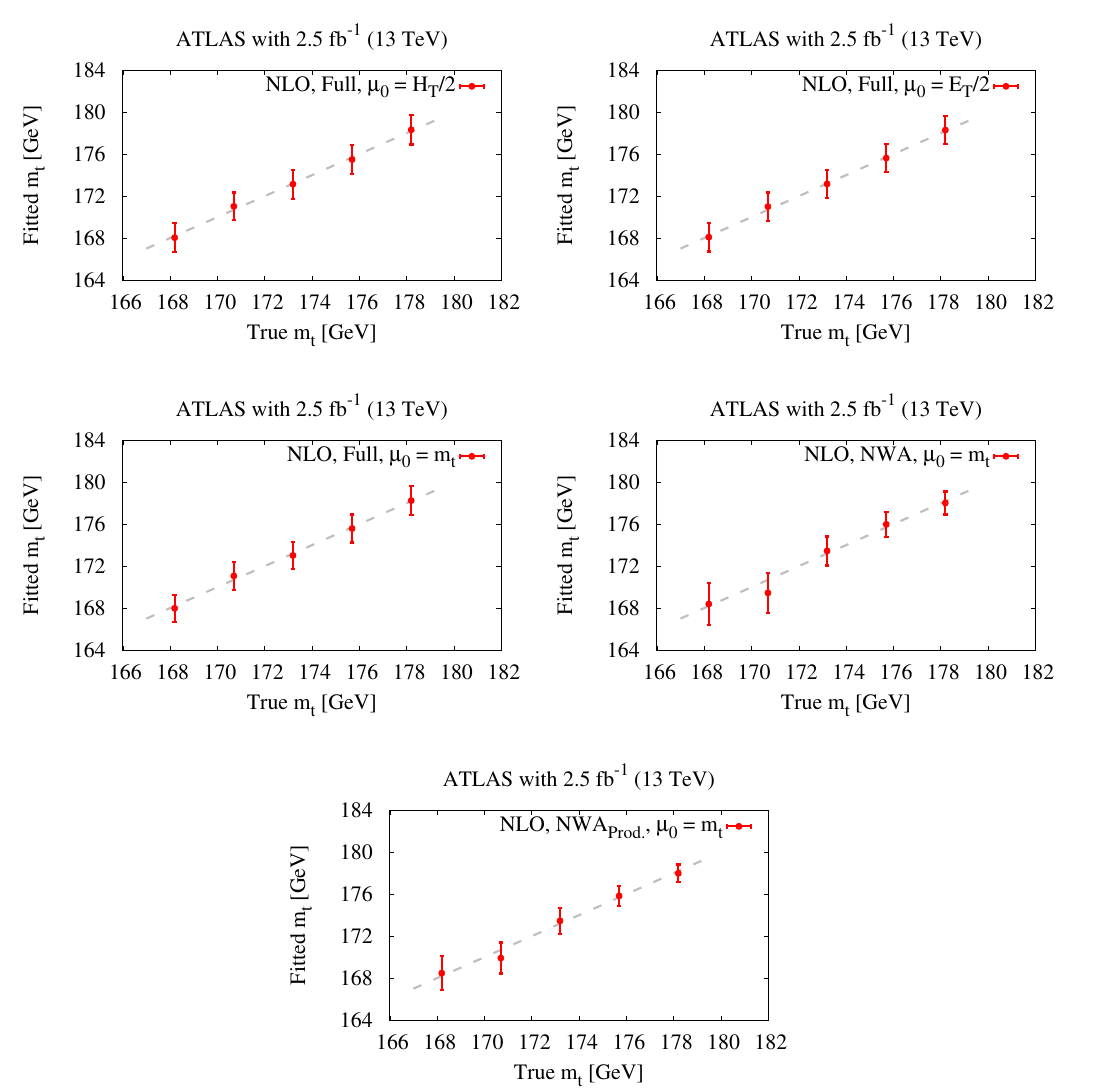
Figure 11 . A di(cid:11)erence between the (cid:12)tted top quark mass and the top quark mass assumed in the theoretical prediction used for the generation of the pseudo-data set. The ATLAS binning is assumed. Luminosity of = 2.5 fb (cid:0) 1 is considered and the CT14 PDF set is employed. The grey L (dashed) line corresponds to "Fitted m t " = "True m t